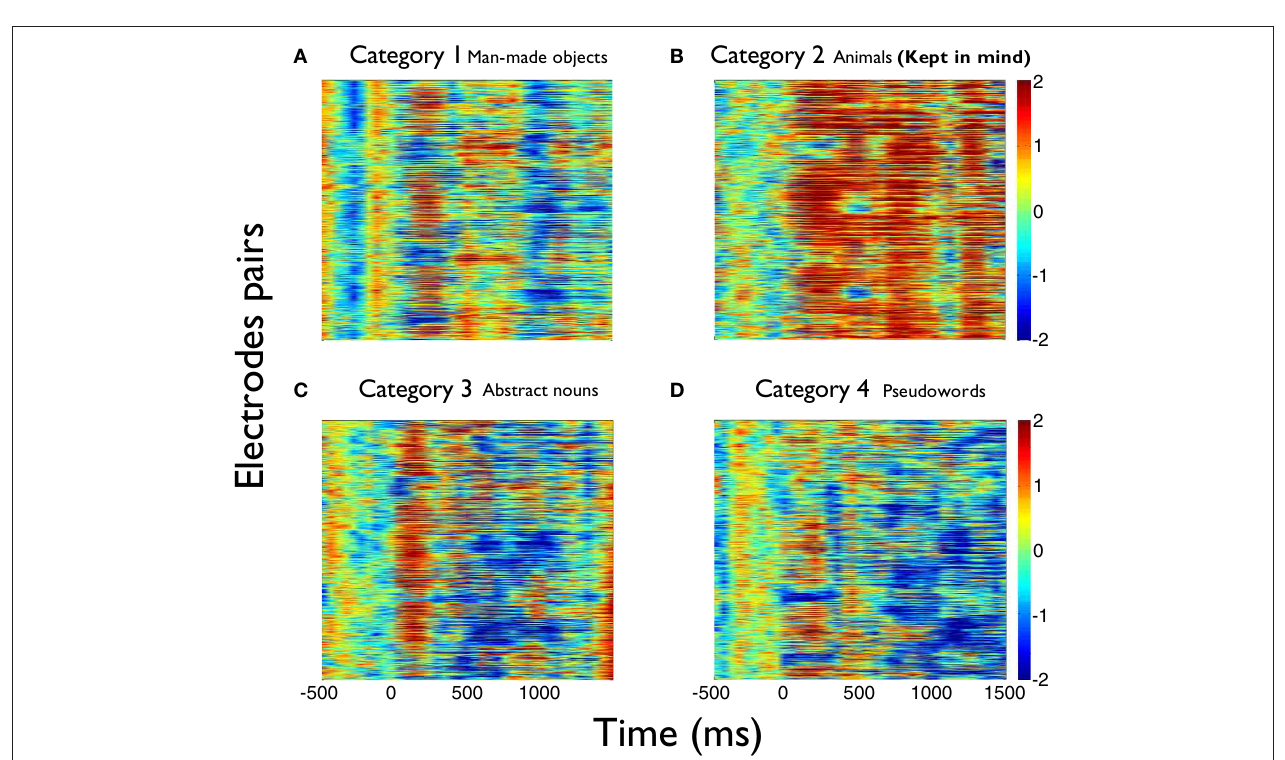
significantly larger compared to the other categories (Kruskal–Wallis test, P < 0 . 01; Tukey’s multiple comparisons). (B) Example box and whisker plots of the phase synchronization values ( Z -scores) obtained between 1 and 6Hz in the time interval between 250 and 800ms poststimulus. On each box, the central mark depicts the median, the edges of the box represents the 25th and 75th percentiles, the whiskers extend to the most extreme data points not considered outliers, and outliers are plotted individually. Notches draw comparison intervals.